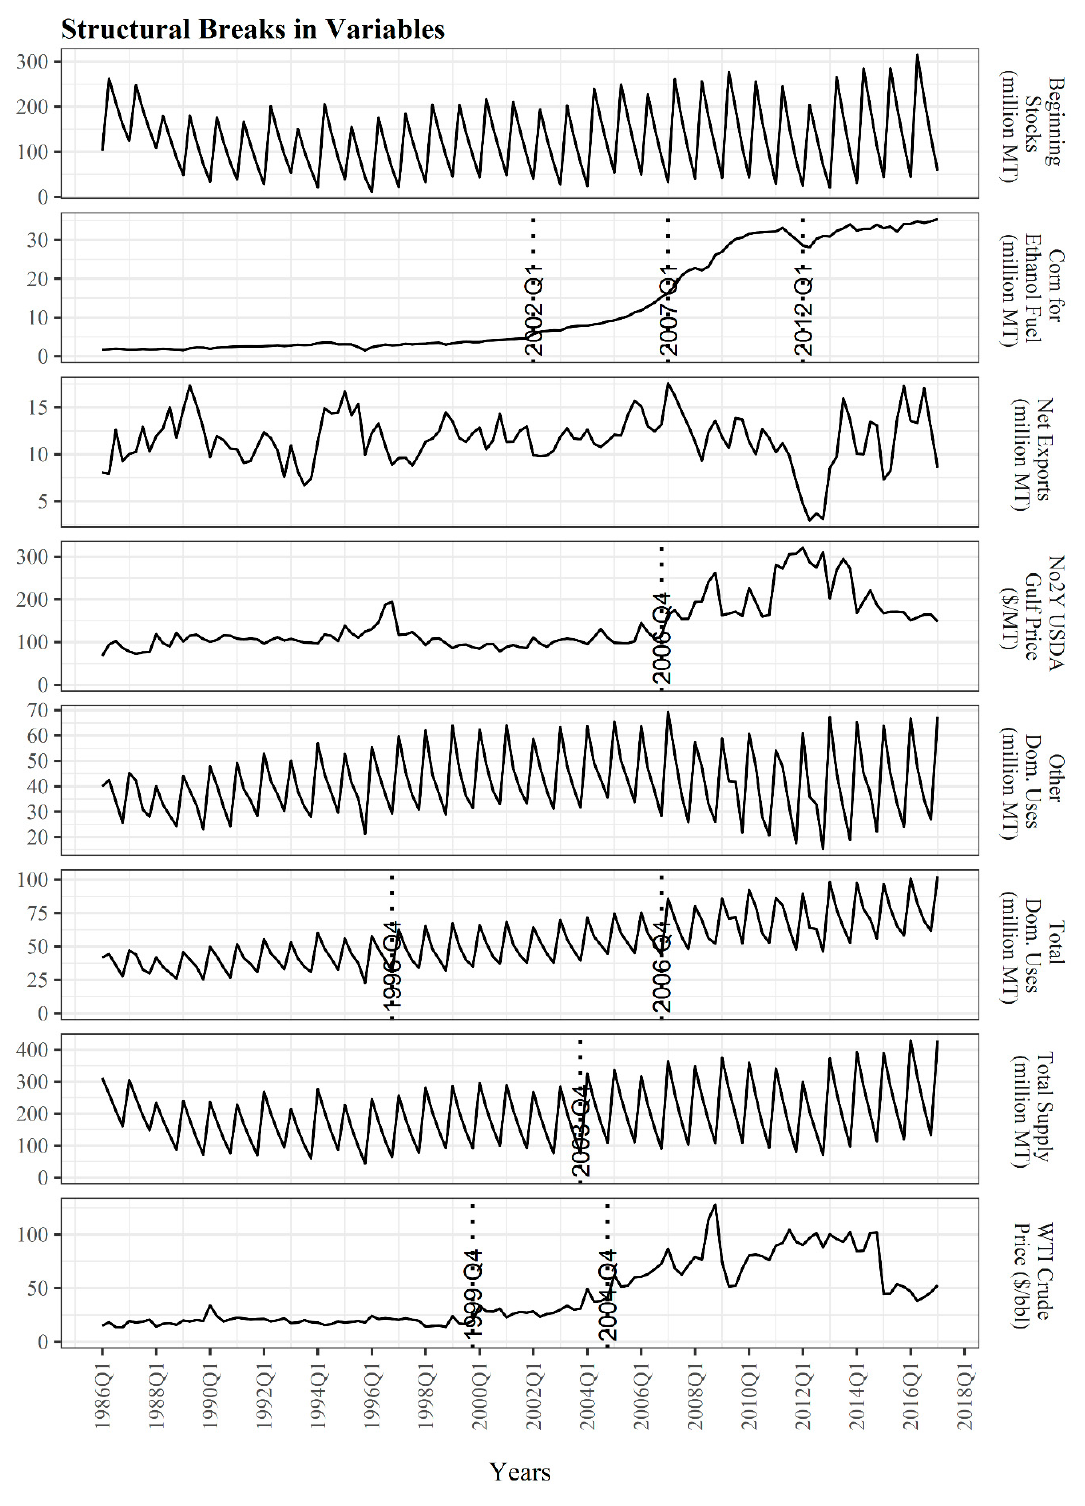
Figure 2. Structural break-dates (vertical lines) in mean of U.S. corn market